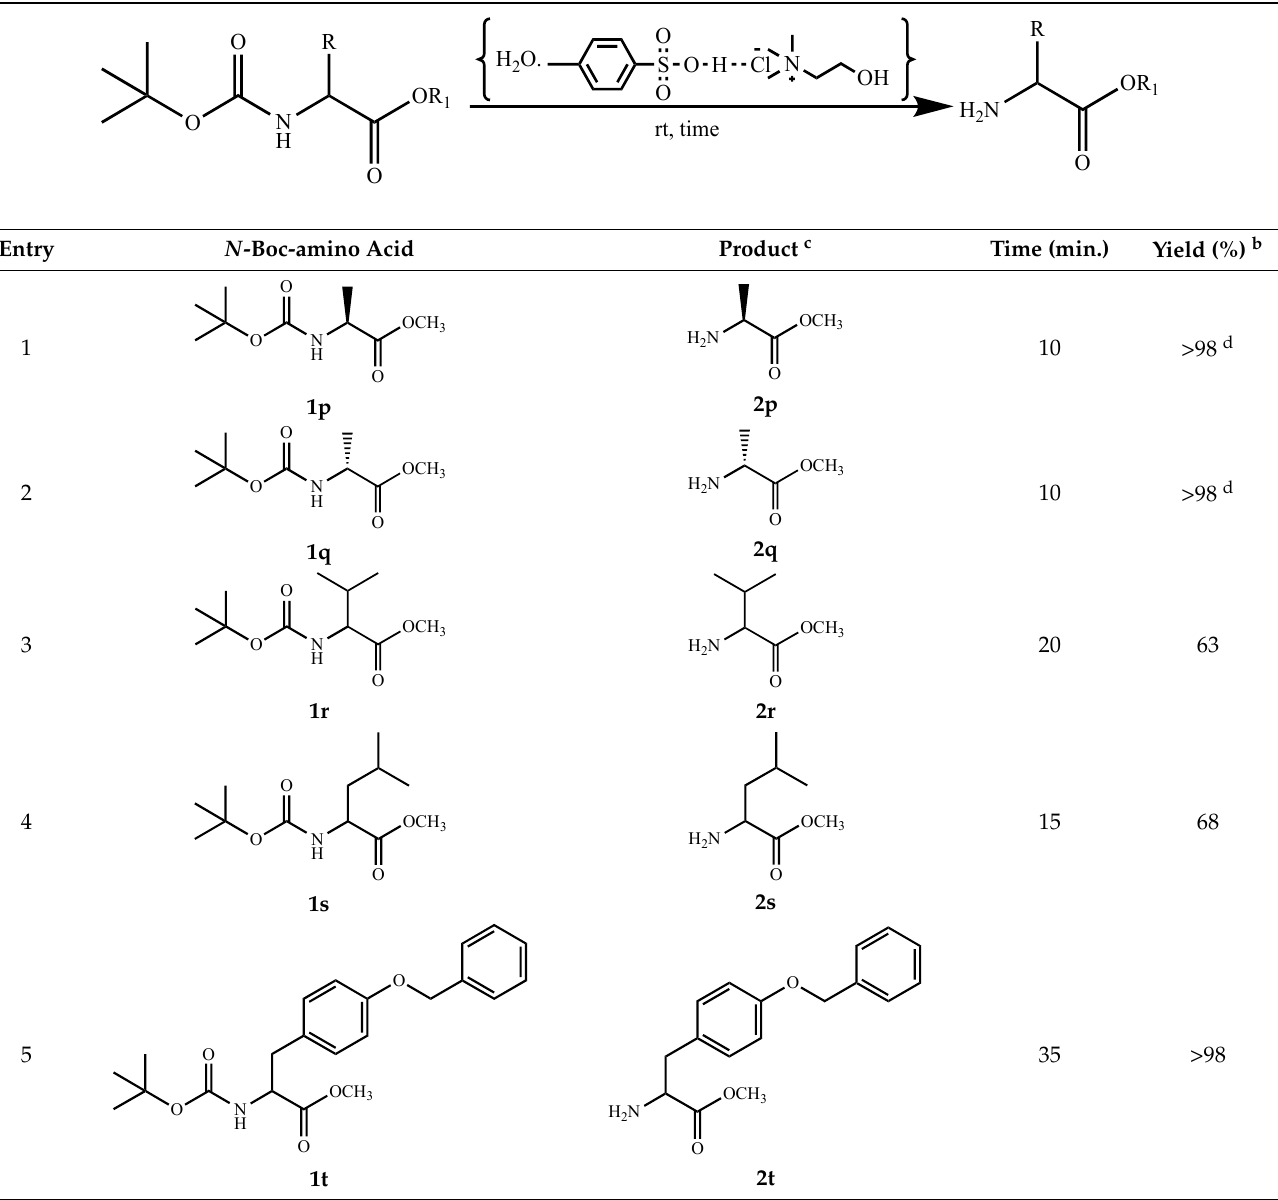
Table 3. DES-catalyzed deprotection of N -Boc amino acid derivatives and N -Boc dipeptide a .